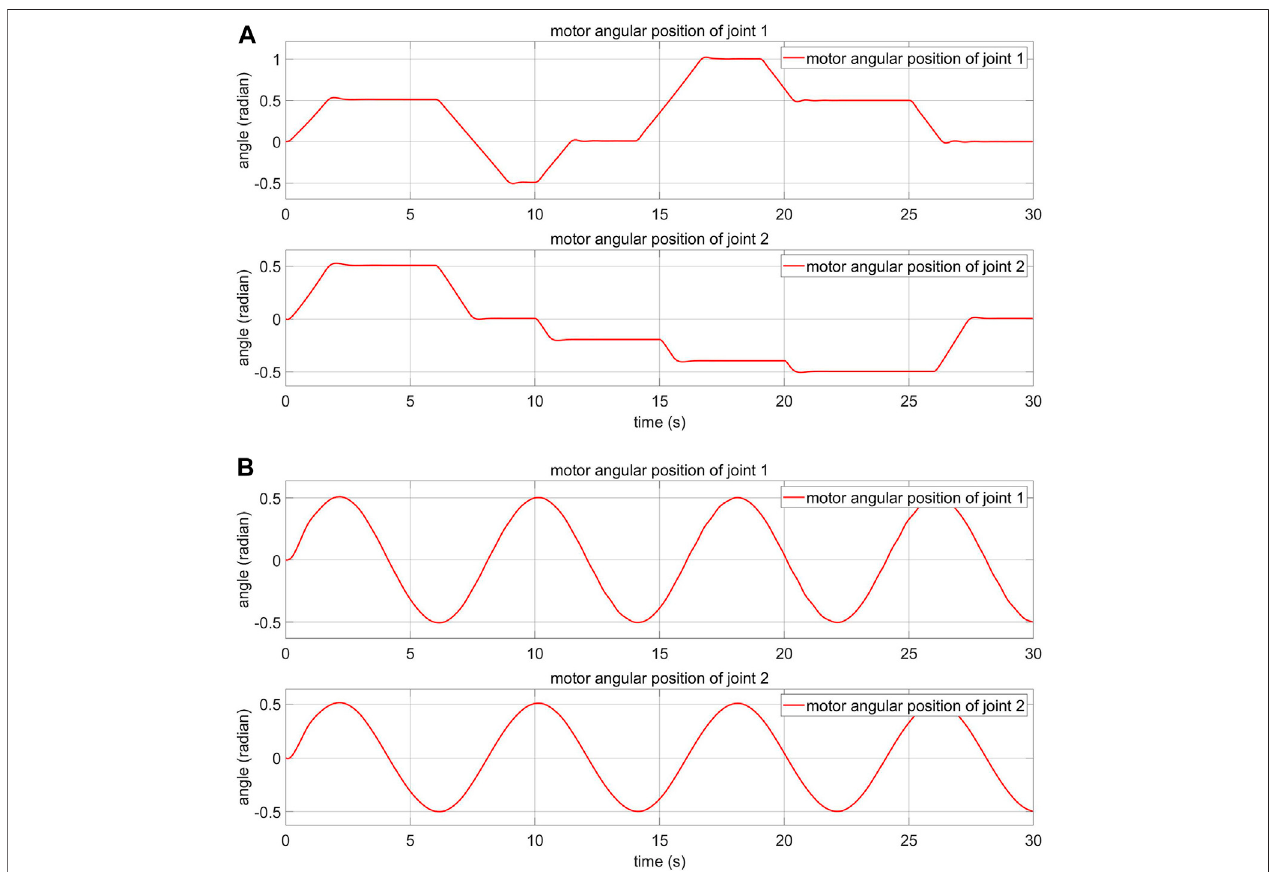
FIGURE 11 | Motor-side response of the FPIC-MRAC (A) step input (B) sine input.